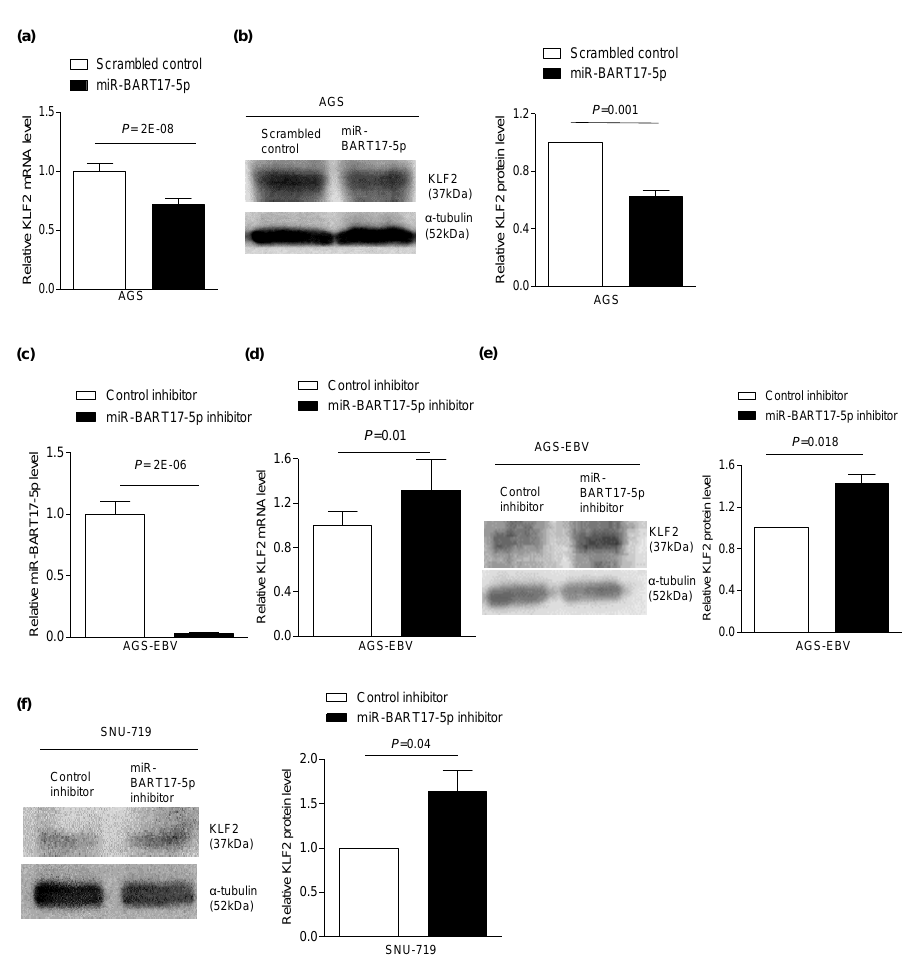
Figure3. Expressionof KLF2 a ff ectedbytransfectionandinhibitionofmiR-BART17-5p. miR-BART17-5p mimic (30 nM) was transfected into AGS cells ( a,b ). ( a ) mRNA level of KLF2 was analyzed by qRT-PCR using a SYBR Green qPCR kit. ( b ) Western blot analysis of KLF2 expression using anti-KLF2 (1:500) antibody. Anti- α -tubulin antibody was used to confirm comparable loading (left panel). Western blot results have been normalized to α -tubulin and are expressed as ratios to the values obtained from the scrambled control. Error bars indicate SD ( n = 3) (Right panel). AGS-EBV and SNU-719 were transfected with 30 nM miR-BART17-5p inhibitor ( c-f ). ( c ) miR-BART17-5p was analyzed by qRT-PCR in three independent experiments. Expression of miR-BART17-5p was normalized with U6 snRNA. ( d ) mRNA level of KLF2 was analyzed by qRT-PCR using a SYBR Green qPCR kit. ( e ) Western blot analysis was performed in three independent experiments to measure KLF2 protein level in AGS-EBV cells. Anti- α -tubulin antibody was used to confirm comparable loading (left panel). ( f ) Western blots were performed in three independent experiments to measure KLF2 protein level in SNU-719 (left panel). Western blot results have been normalized to α -tubulin and are expressed as ratios to the values obtained from the control inhibitor. Error bars indicate SD ( n = 3) (right